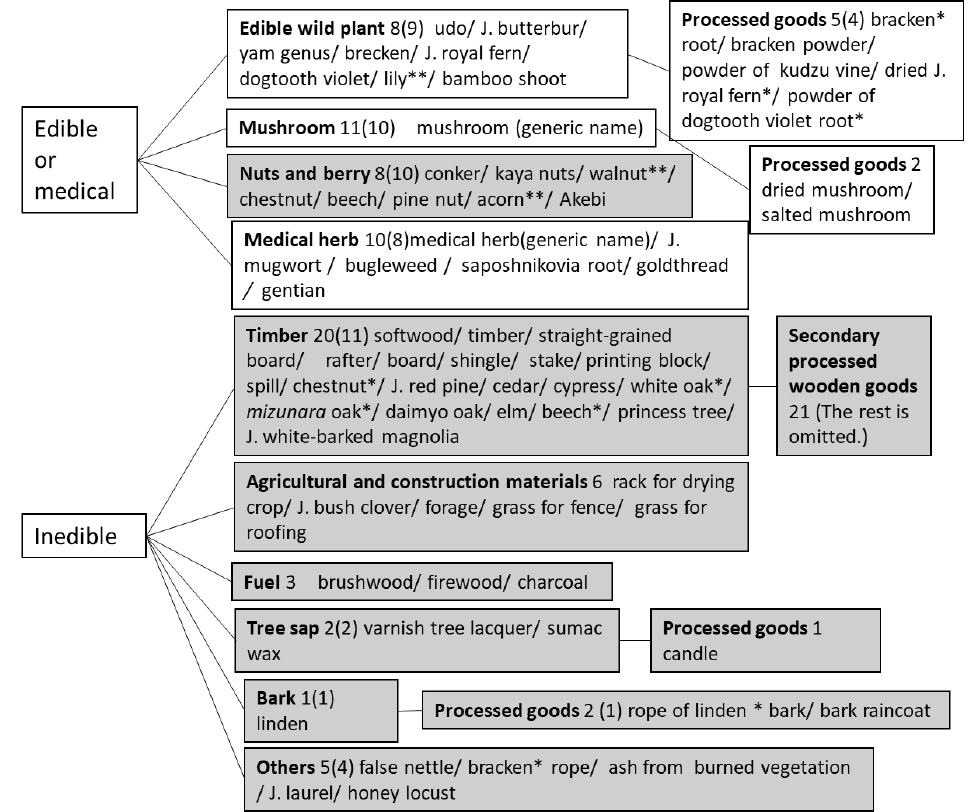
Figure 4. Forest products from vegetation in Iwate for various uses. The numerals express number of products and in round brackets the number of species identified. “J.” means Japanese. Gray boxes indicate the category contains trees. “Agricultural and construction materials” and “Others” include both herbages and trees. * Same as another category, mentioned above. ** Includes two species or varieties.